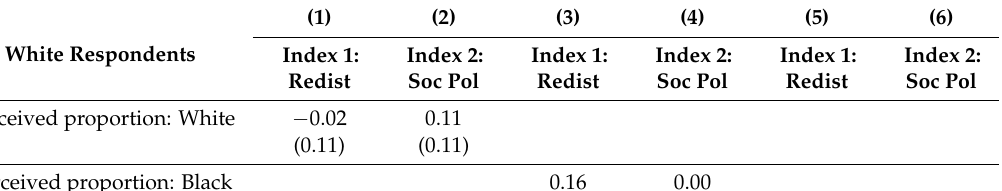
Table A1. Bivariate ordinary least squares (OLS) regression models of support for redistribution and social policies.